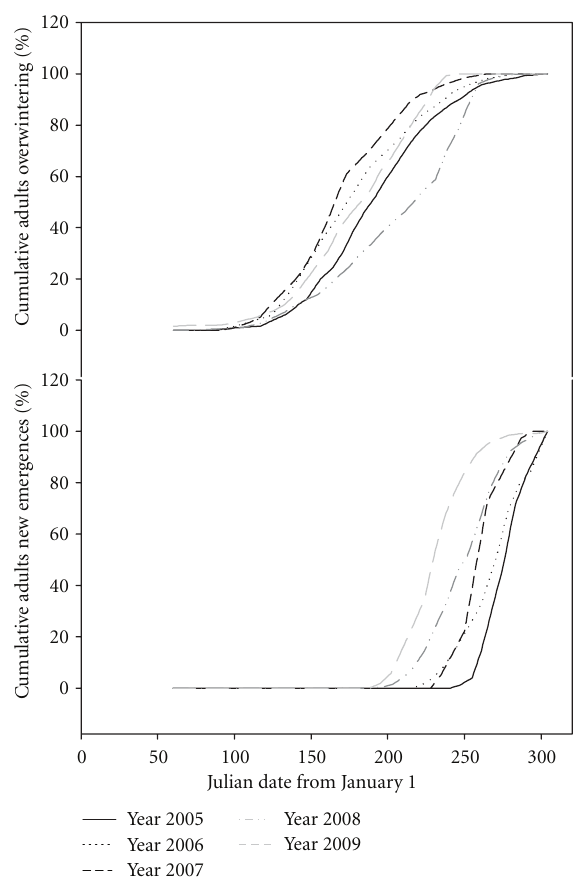
Figure 4: Cumulative percentage of Capnodis tenebrionis (over- wintering and emerging) adults. The grey line refers to semiarid climate, and the black line refers to temperate